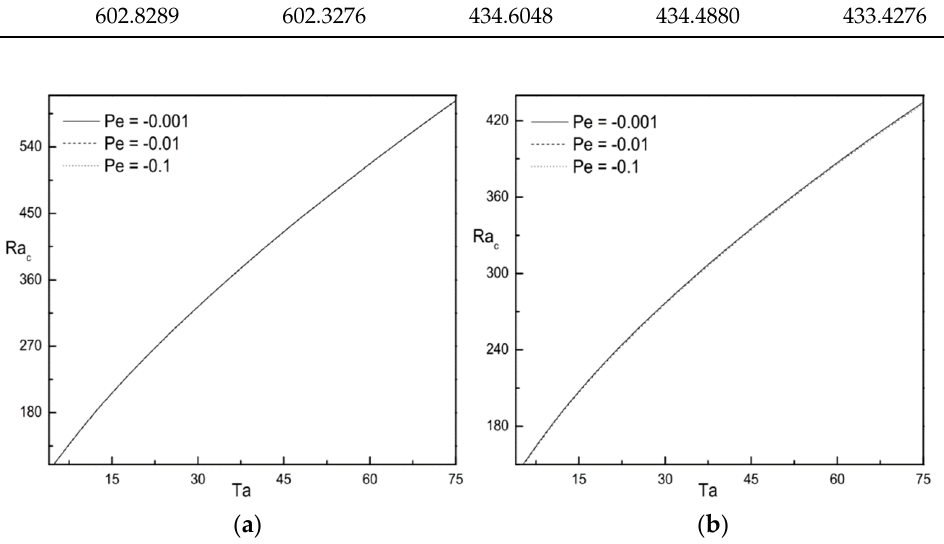
Figure 5. Dependence of Ra c on Ta for ( a ) Da = 0.01 and ( b ) Da = 0.1.